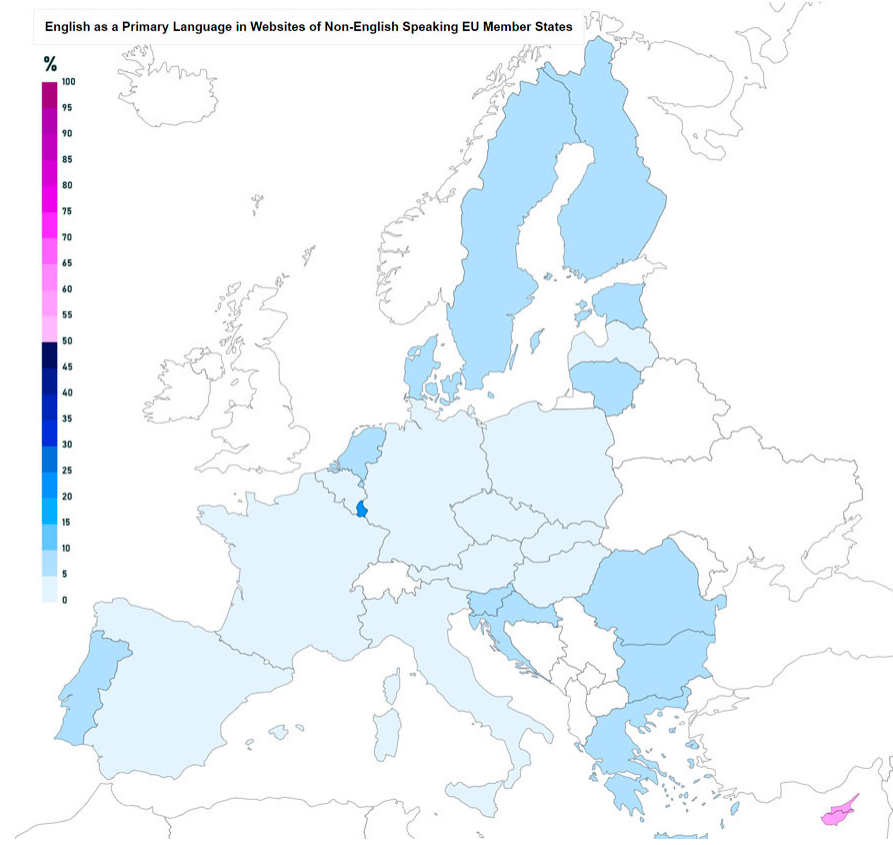
Figure 11. English as a Primary Language in Websites of Non-English Speaking EU Member States.